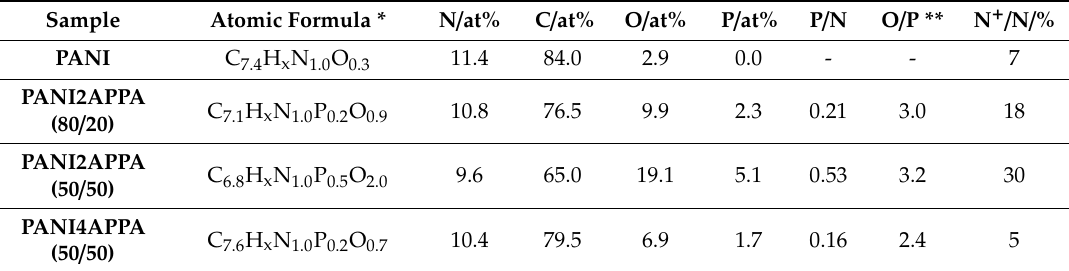
Table 1. Chemical composition and atomic ratios obtained from the XPS spectra of polyaniline